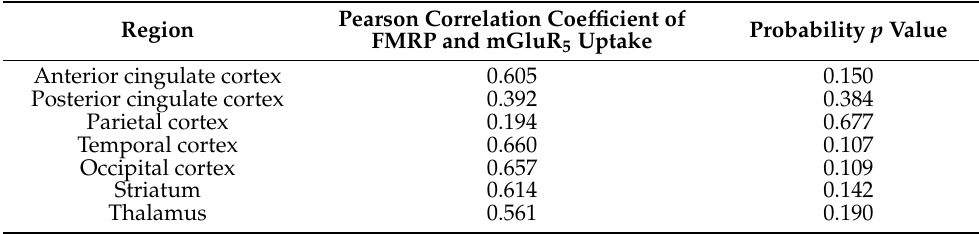
Table 4. Pearson correlation coefficient R between Fragile X Mental Retardation Protein (FMRP) in nanogram per microgram total protein and ratios of 3-[ 18 F]fluoro-5-(2-pyridinylethynyl)benzonitrile ([ 18 F]FPEB) uptake in the regions of interest (ROIs) to uptake in the cerebellum of men with the full mutation (FM) or an allele size mosaicism (FXS-M) of fragile X syndrome [83].